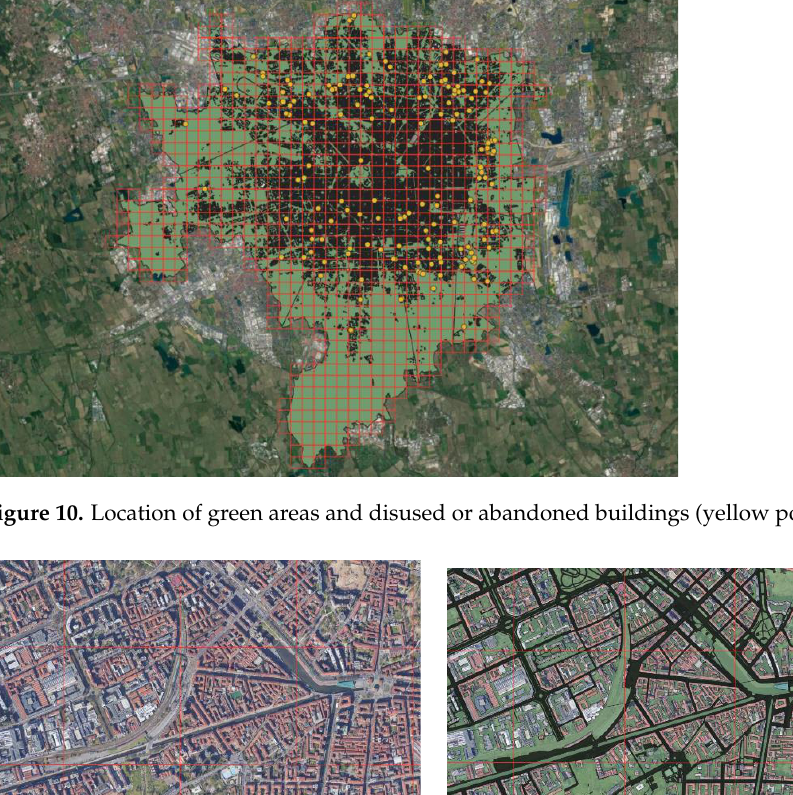
density; yellow, medium-density; and red, high-density.